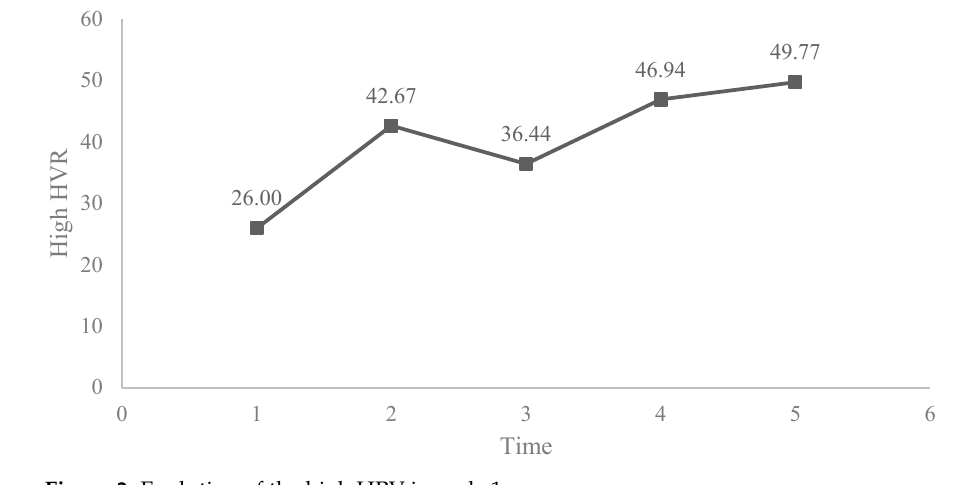
Figure 2. Evolution of the high HRV in cycle 1.